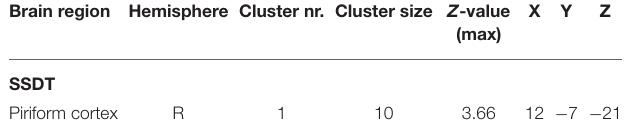
TABLE 5 | Location of brain activations during OI fMRI associated with olfactory test scores and Mini Mental Status Examination score. Brain region Hemisphere Cluster nr. Cluster size Z -value